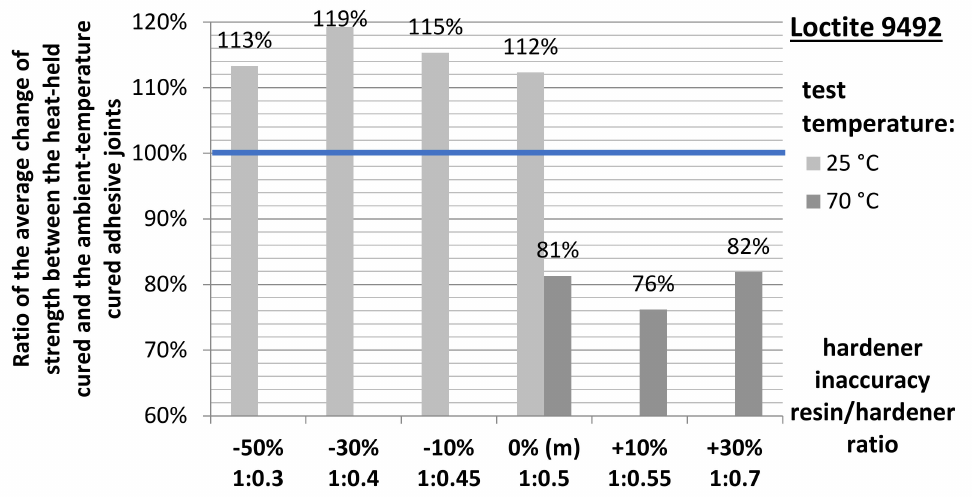
Figure 13. Statistically significant change in the ratio of the average strength between the heat-cured and the ambient temperature-cured adhesive joints.